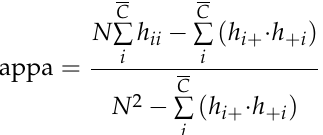
Table 3. Land cover types and total number of samples in the Salinas dataset.